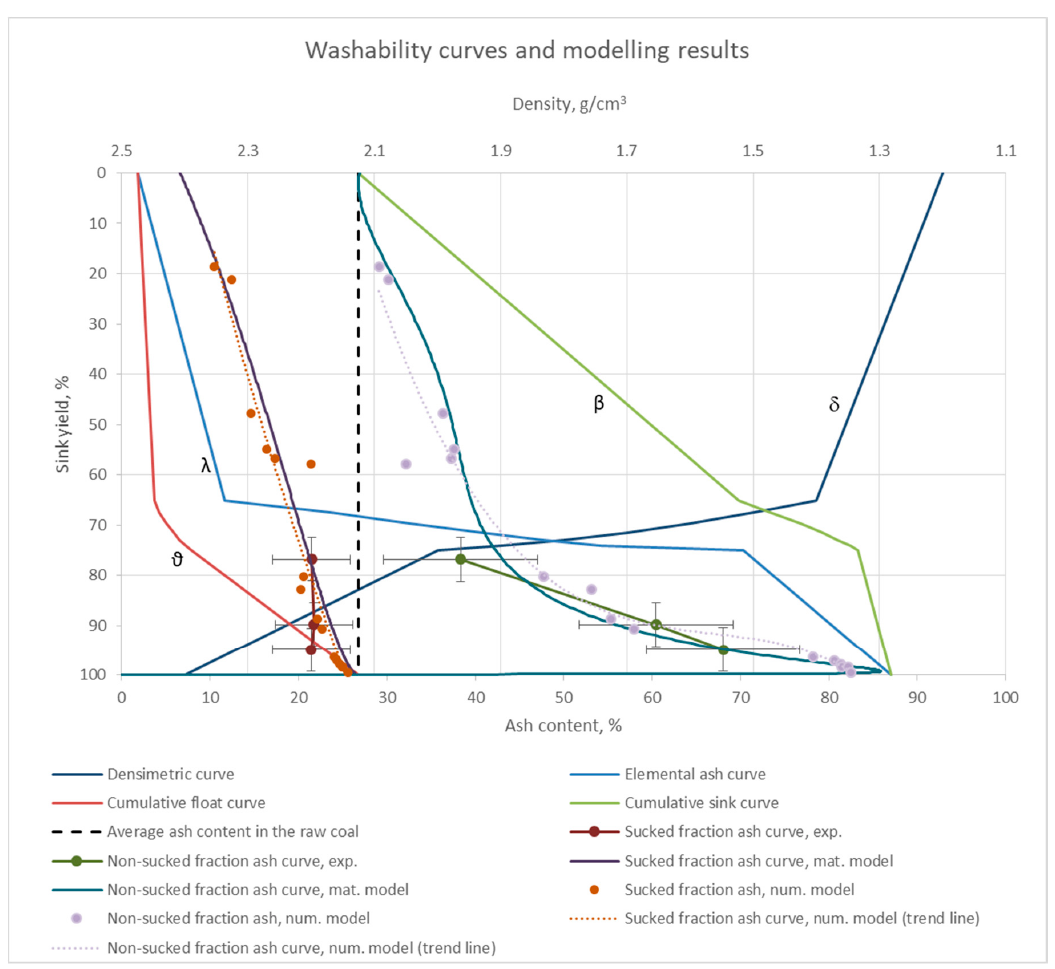
Figure 13. Summary of washability curves, enrichment curves, experimental results and modelling results—feed material no. 1 in grain size class 0–20 mm.